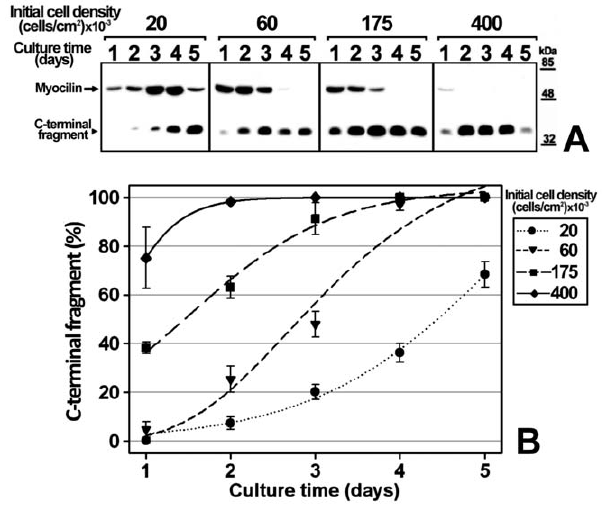
Figure 1. Effect of culture time and initial cell density on recombinant myocilin proteolytic processing. (A) HEK-293T cells were seeded in 6-well plates at the indicated cell densities. Cells were transfected with a cDNA construct encoding myocilin-myc as described in Materials and Methods. After transfection, they were cultured in DMEM containing 10% FBS for 5 days and the culture media were substituted daily by equal volumes of fresh medium. Extracellular recombinant myocilin was analyzed by 10% polyacrylamide SDS-PAGE and Western blot using an anti-myc monoclonal antibody (Santa Cruz). Equal amount of total protein was loaded into each well. The arrow and arrowhead indicate the position of full-length myocilin (55-kDa), and the 35-kDa C-terminal fragment, respectively. (B) Quantitation by densitometry of the C-terminal fragment detected in A. Values represent the percentage of extracellular myocilin C-terminal fragment expressed as: 100x [C-terminal fragment/(C-terminal fragment + full length myocilin)] . Error bars correspond to the SD of three independent experiments carried out in triplicate Two-way ANOVA showed an effect of culture time ( p , 0.001) and cell density ( p , 0.001), and a significant interaction between them (p , 0.001).